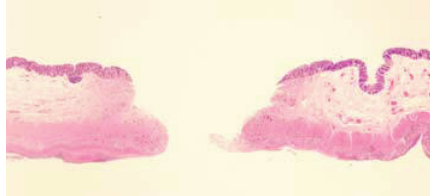
Figure 3: Microscopic specimen demonstrates punched-out ulcer. There is active inflammation around the ulcer. (haematoxylin and eosin ×